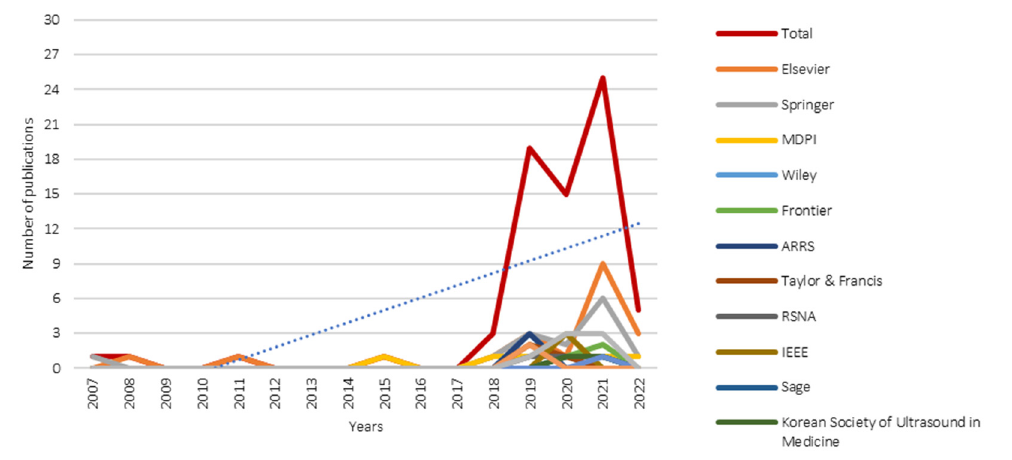
Figure 8. Temporal scientometric analysis of the included review works.